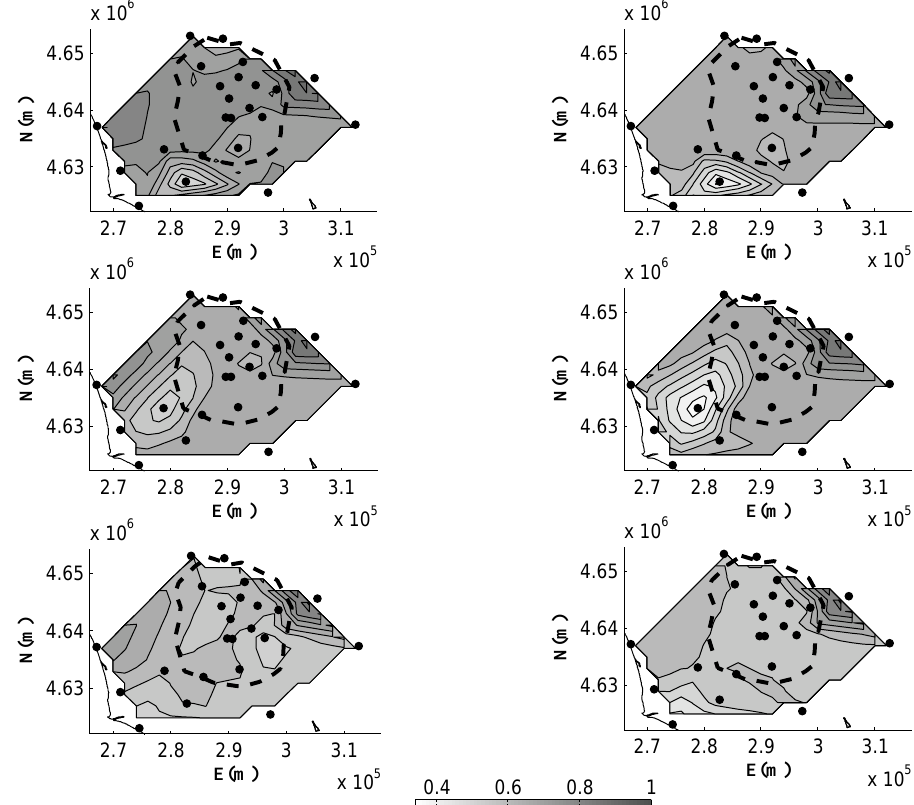
Fig. 7. Rome area isoinformation contours for sampling time intervals of d = 1 day, 1 week and 1 month for summer (left) and winter (right) seasons. The colour bar varies from 0.34 to 1 and shows the value achieved by the nontransferred information index. The dashed line represents the Roman